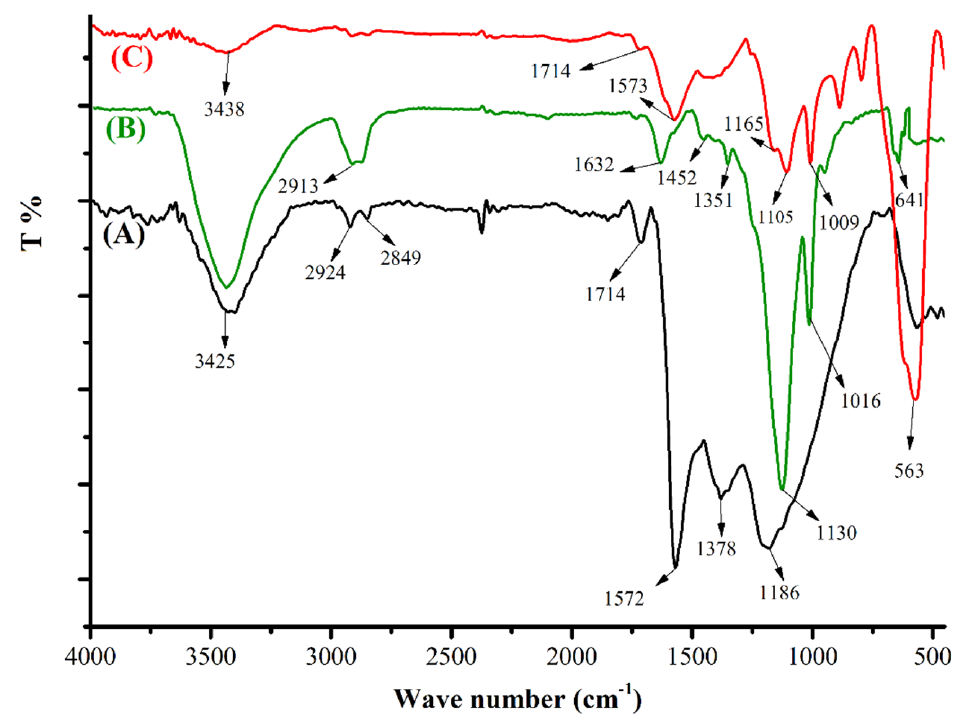
Figure 1. FTIR spectra of ( A ) activated MWNTs, ( B ) CdS nanoparticles, and ( C ) Fe 3 O 4 @MWCNT- CdS nanomaterial.